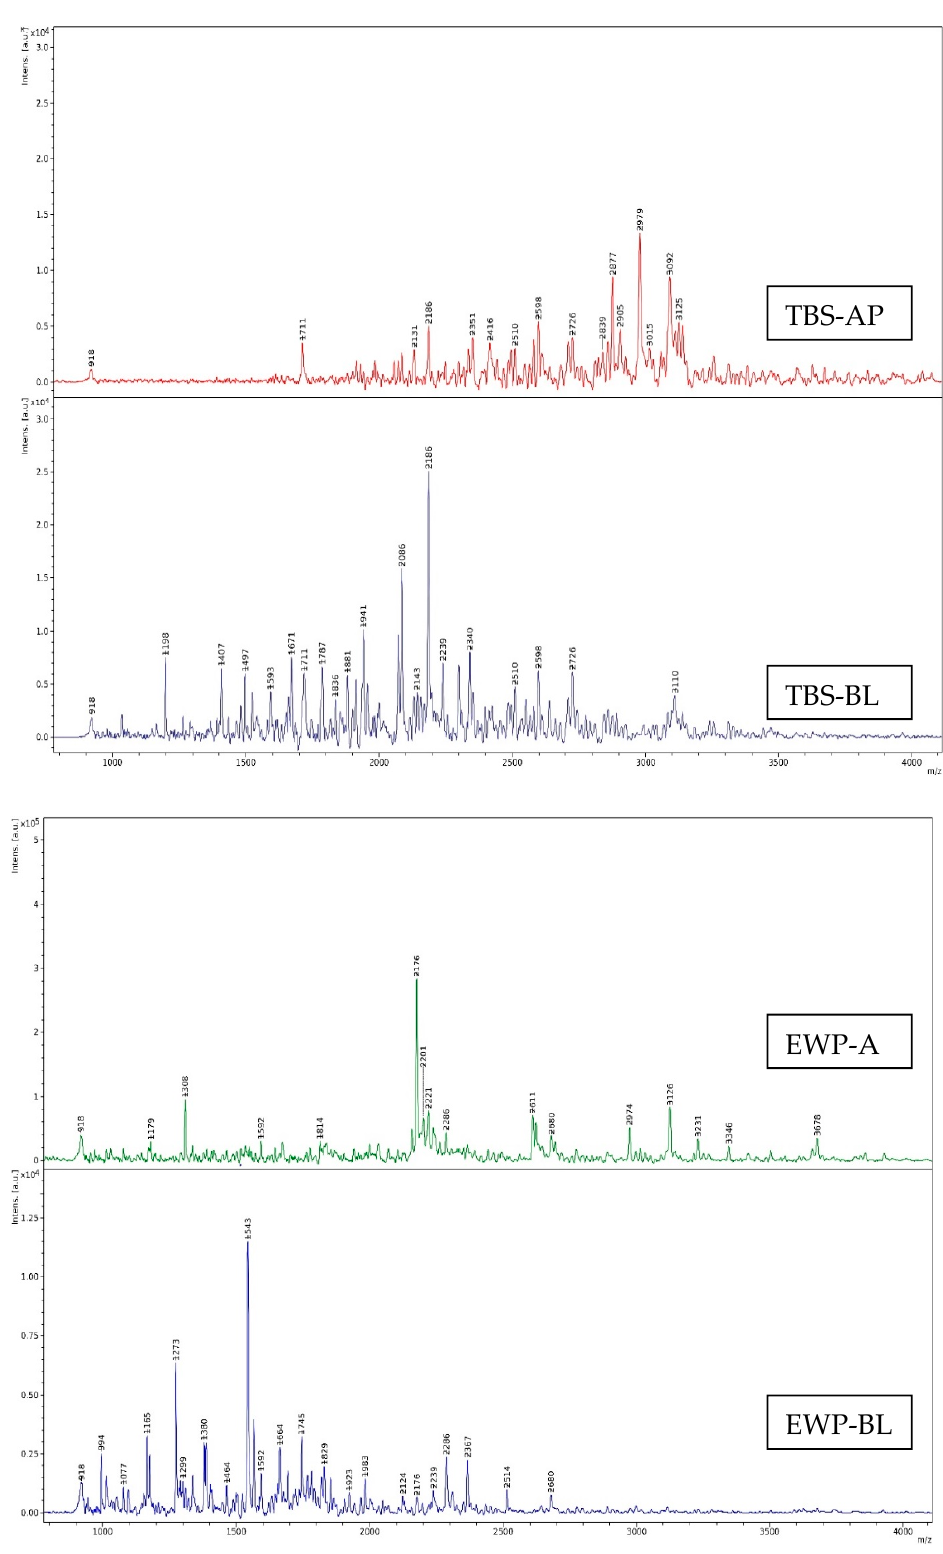
Figure 7. Size distribution of peptides in hydrolyzed proteins including red kidney bean protein (RKB), threadfin bream surimi (TBS) and egg white protein (EWP) before transport (AP) and after 4-h transport appeared as basolateral (BL)-side permeates.